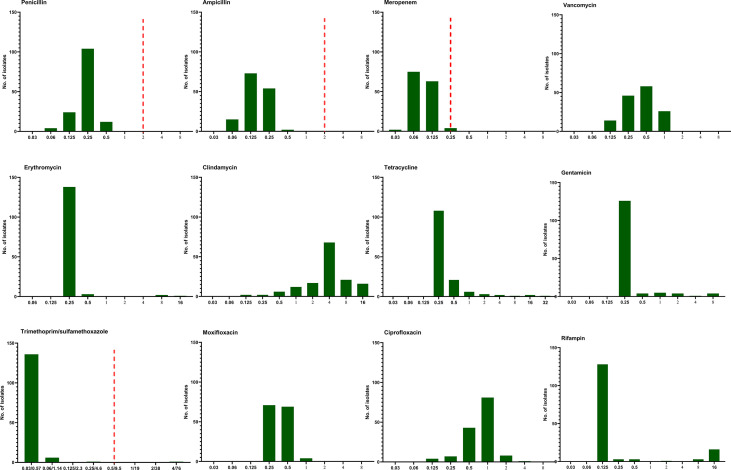
The distribution of the Minimum inhibitory concentration (MIC) 144 clinical unique strains of L. monocytogenes for 12 antibiotics. Redline: the breakpoint for L. monocytogenes by CLSI.